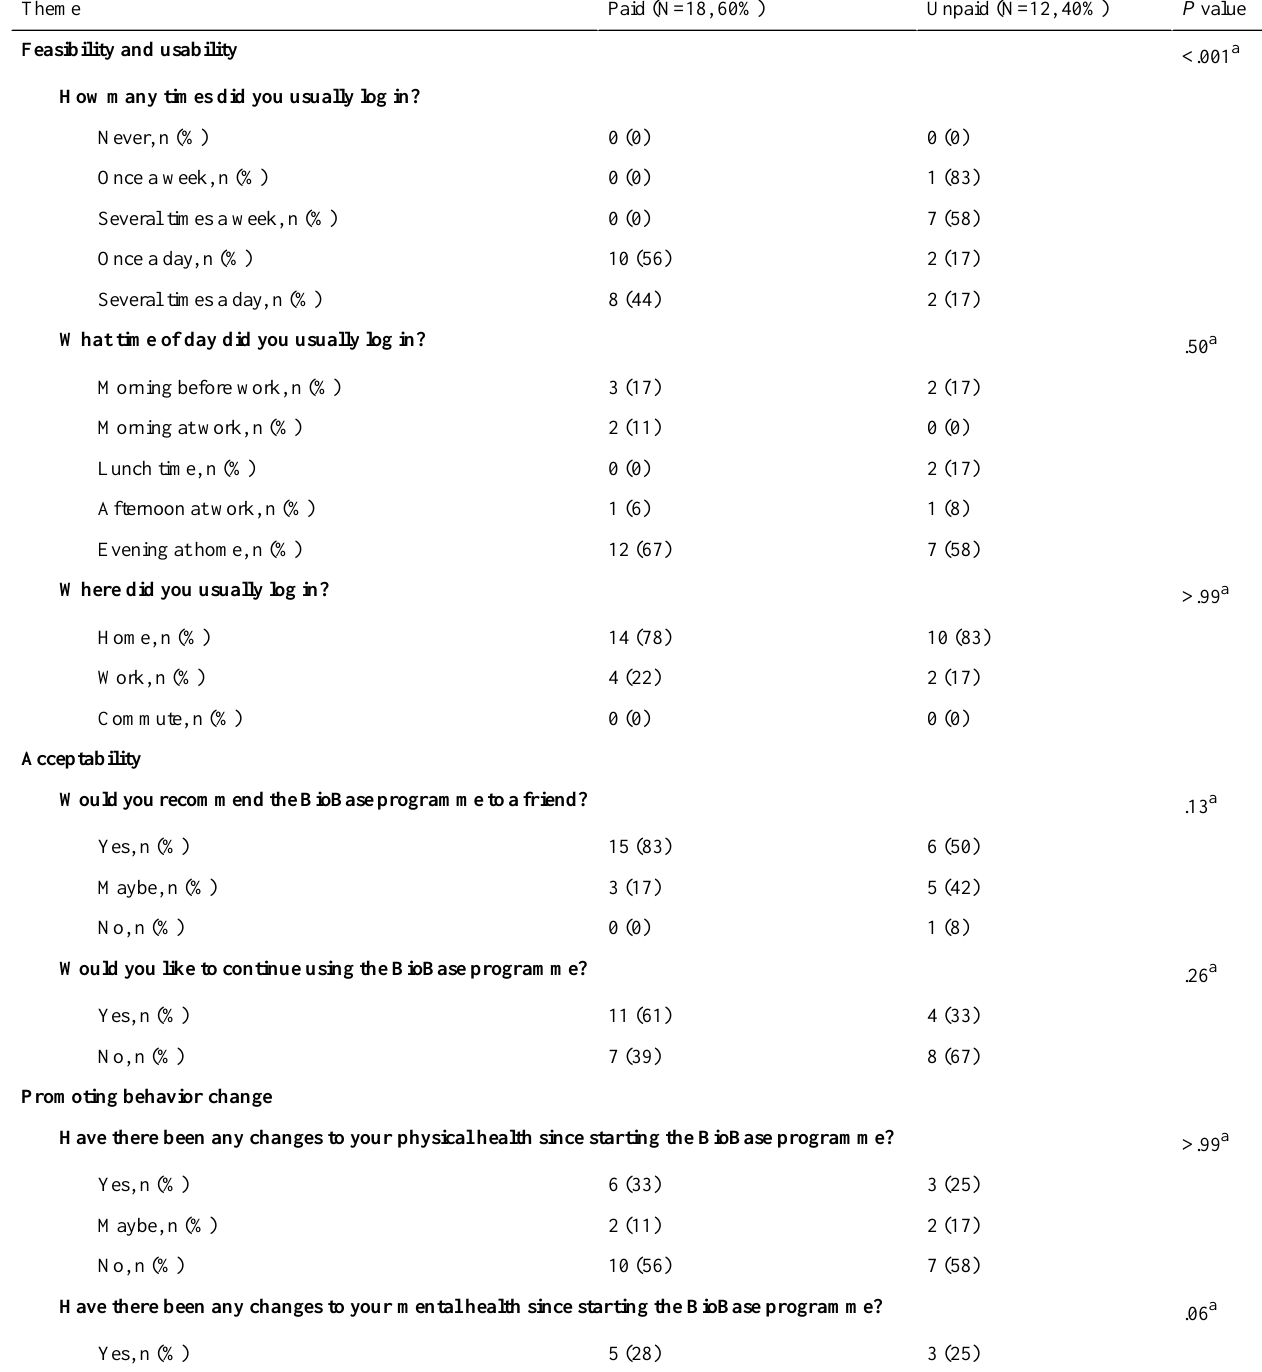
Table 2. Feedback questionnaire results on intervention engagement, usability, and self-reported behavior